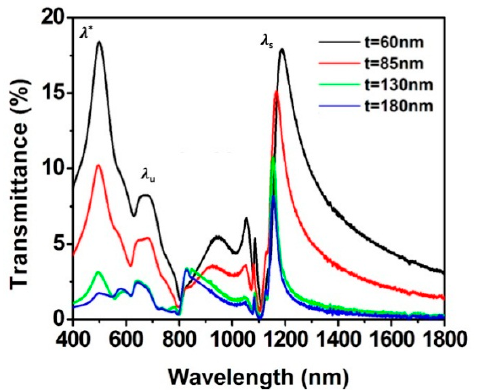
Figure 4. Transmission spectra (in air) of different samples with period of 675 nm, diameter of 280 nm and Au film thickness of 60 nm (black), 85 nm (red), 130 nm (green), and 180 nm (blue).